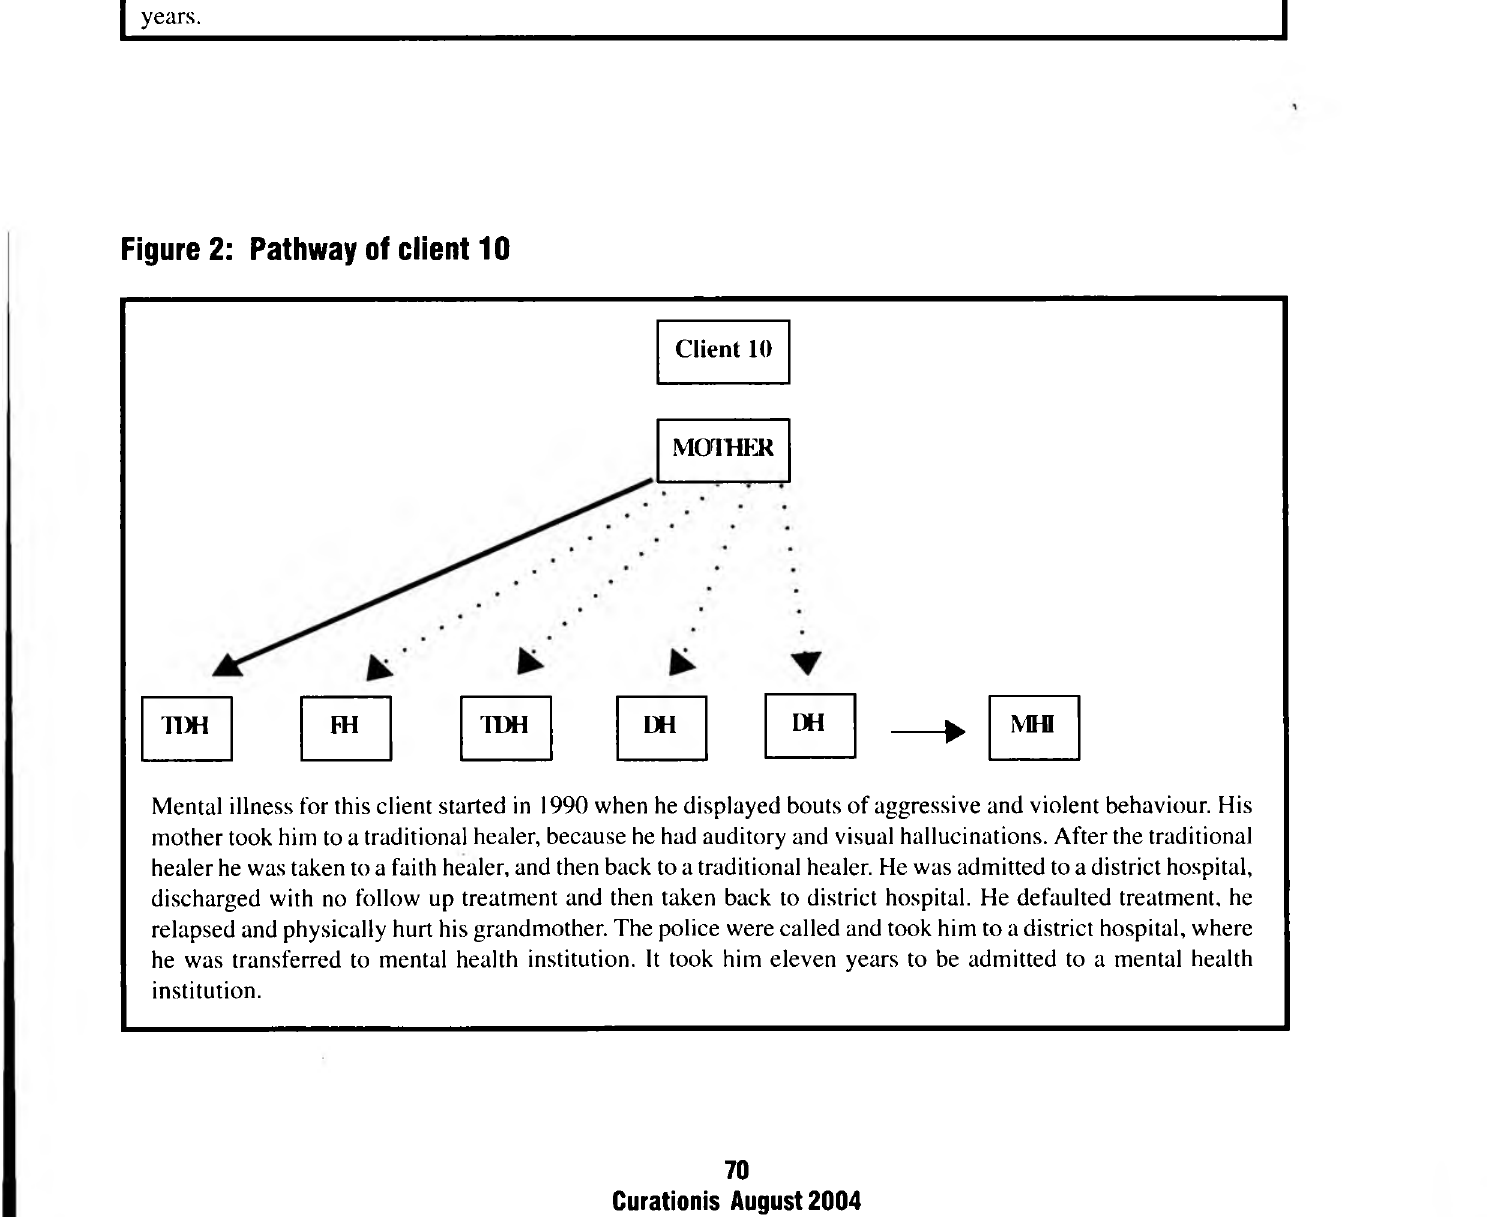
Figure 2: Pathway of client